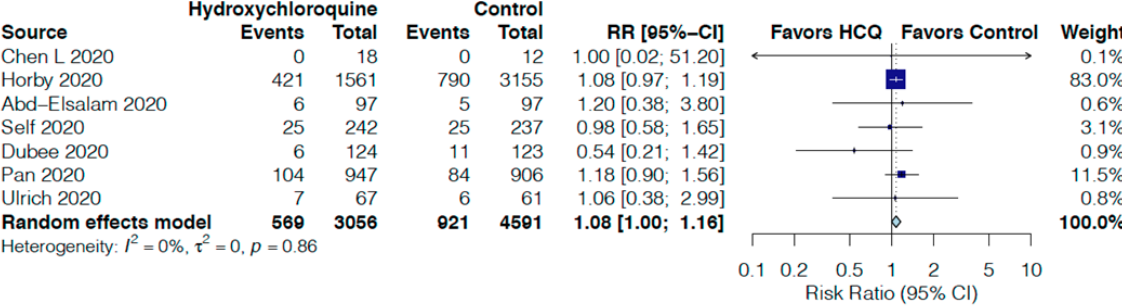
Figure 3. Effect of hydroxychloroquine on all-cause mortality at 14 days in hospitalized COVID-19 patients.